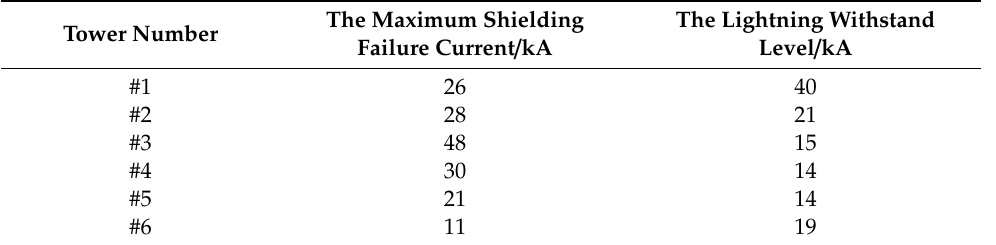
Table 10. The maximum shielding failure current and the lightning withstand level of each tower.